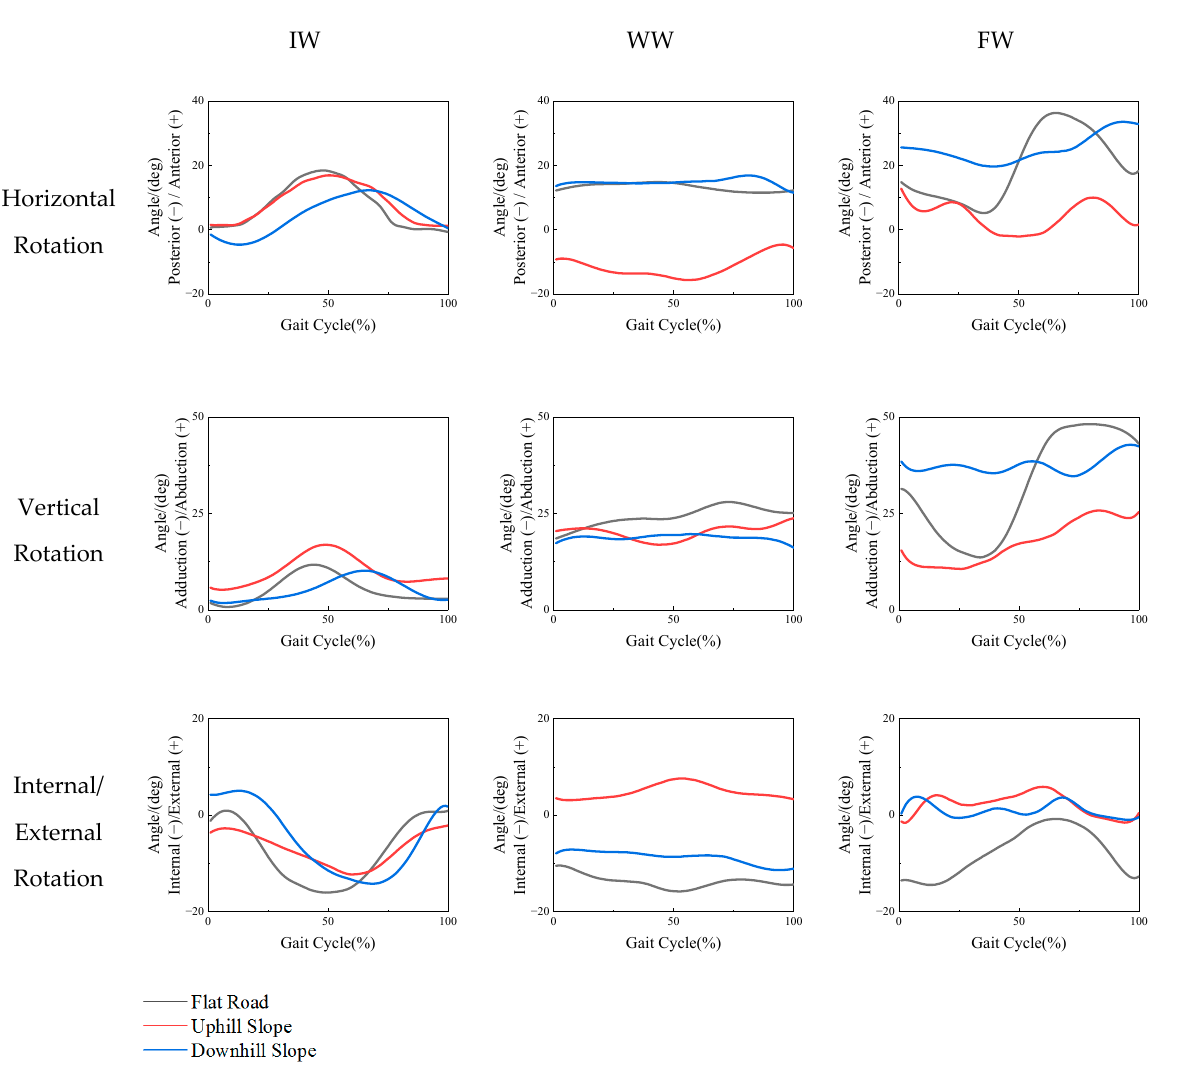
Figure 5. Comparison of the effects of different tasks on the motion of the shoulder joint. It was logical that the shoulder motion of the man going uphill with a WW was more affected in the horizontal rotation plane with a peak posterior angle of 15.60° and in the internal/external rotation plane with a peak external angle of 7.63°. With FW ambulation on the uphill and downhill slopes, the kinematic patterns of the shoulder in the horizontal and vertical planes were obviously changed compared with those observed on the flat